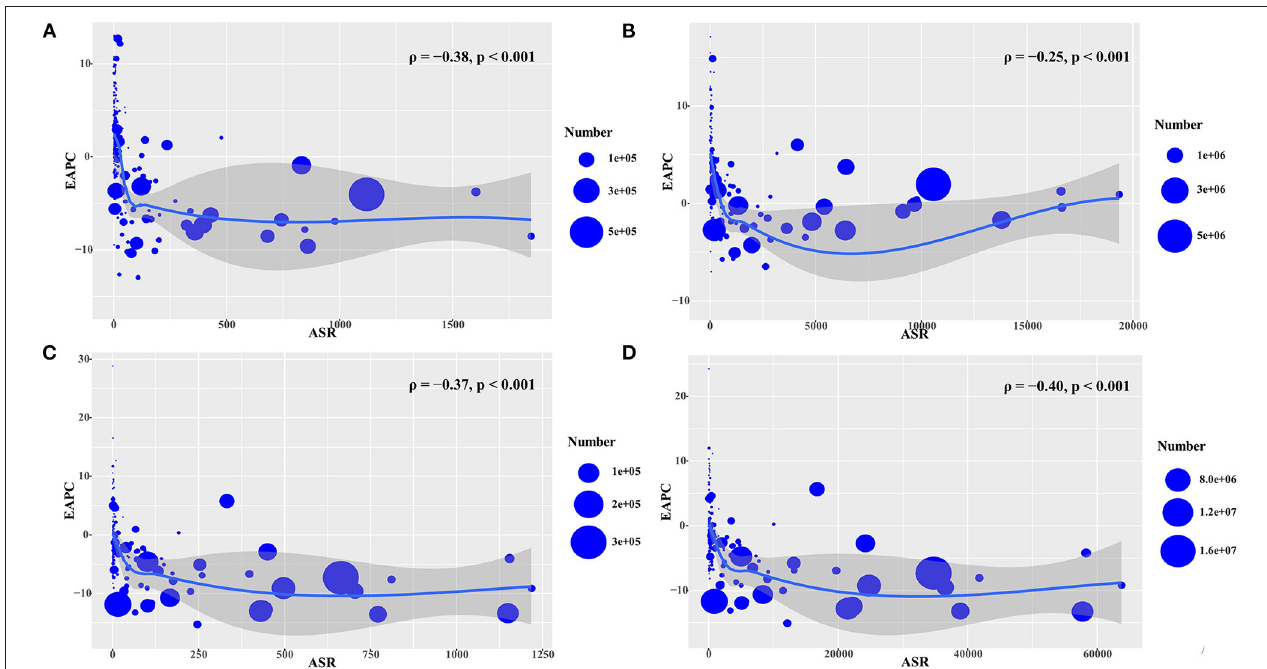
FIGURE 4 | The association between EAPCs and ASR in 2005 at the national level during the period 2005–2019. The EAPCs of HIV/AIDS including the incidence (A) , prevalence (B) , death (C) , and DALYs (D) had a negative association with the corresponding ASR in 2005. The associations were calculated using Pearson correlation analysis. The circles represent countries that had available HDI data, and the size of circles changes according to the number of HIV/AIDS cases in the corresponding countries in 2005. ASR, age-standardized rate; EAPC, estimated annual percentage change; DALYs, disability-adjusted life